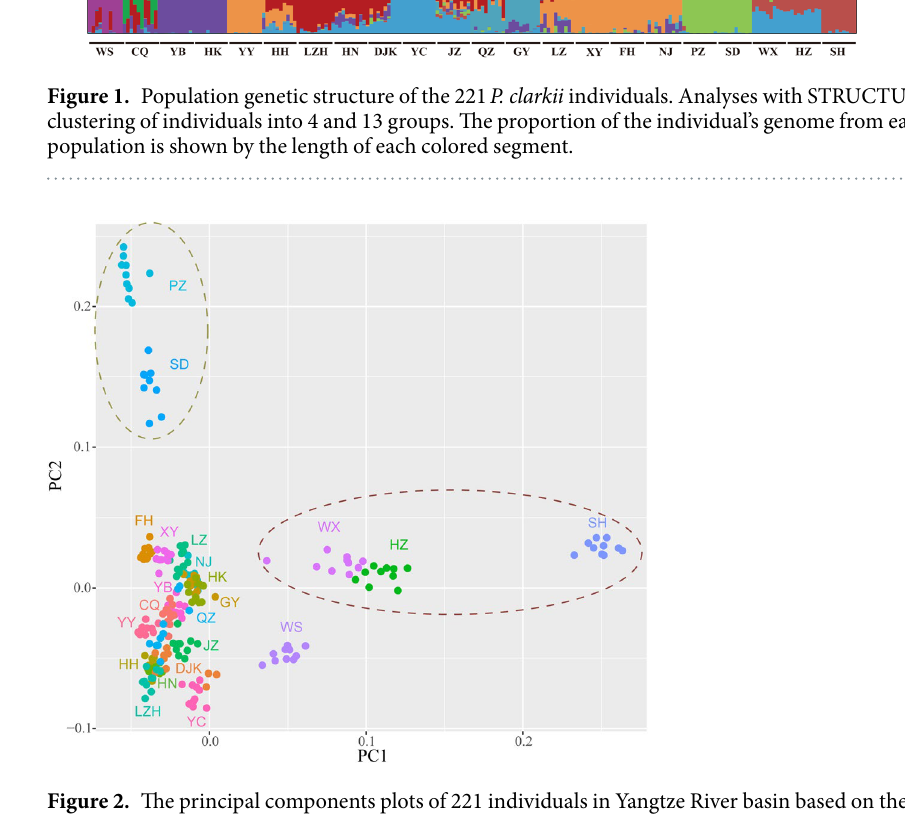
Figure 2. The principal components plots of 221 individuals in Yangtze River basin based on the 1st an 2nd eigenvectors. The different colors represent the different crayfish populations. The dashed circles indicate the individuals from the lower reaches of Yangtze River basin and Huai River basin,